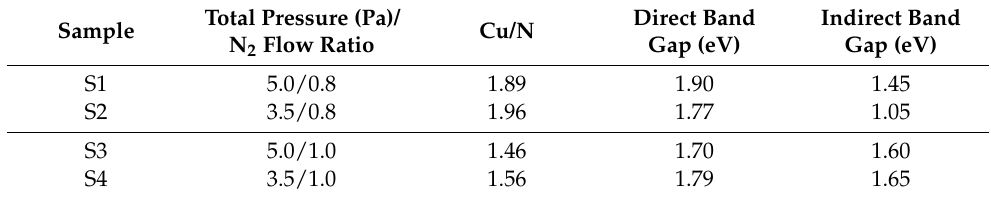
Figure 6. Calculation of the band gap energy of Cu 3 N films deposited at different pressures and in different gaseous environments: ( a ) ( αhν ) 1/2 vs. hν plot for the determination of the direct band gap; ( b ) ( αhν ) 2 vs. hν plot for the determination of the indirect band gap. Table 6. Direct and indirect band gap energy calculated for the samples under